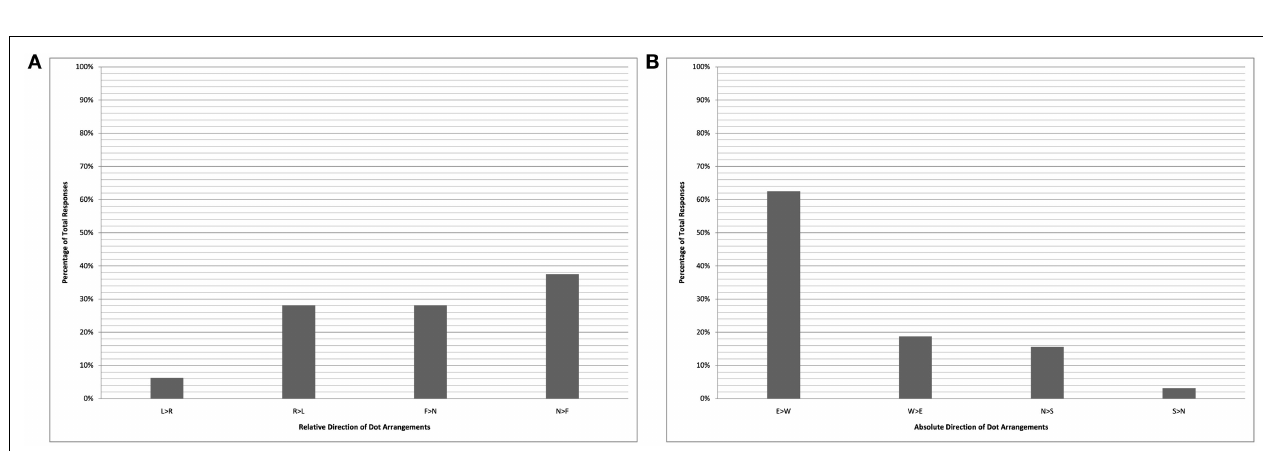
FIGURE 2 | KuukThaayorre speakers (card task). Chart shows relative coding of data (A) and absolute coding of data (B) . Key (A) : L > R “left-to-right”; R > L “right-to-left”; F > N “far-to-near”; N > F “near-to-far.” Key (B) : E > W “east-to-west”;W > E “west-to-east”; N > S “north-to-south”; S > N “south-to-north.”